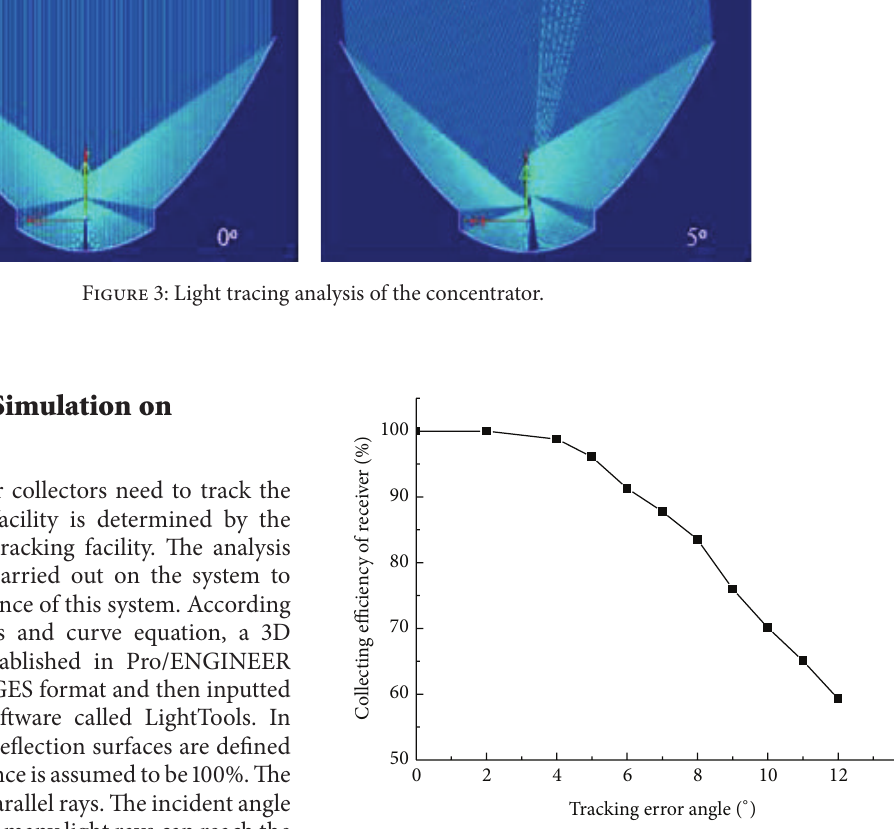
Figure 4: The efficiencies of concentrator change with the deviation of the tracking